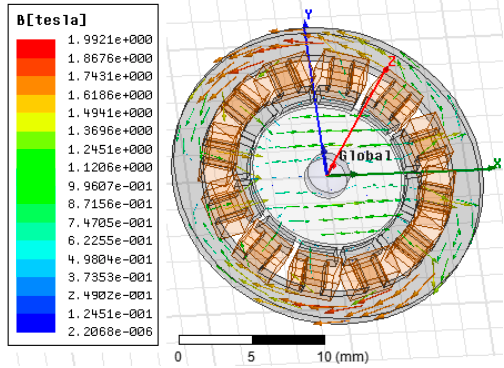
Figure 4. Distribution of magnetic flux density B .